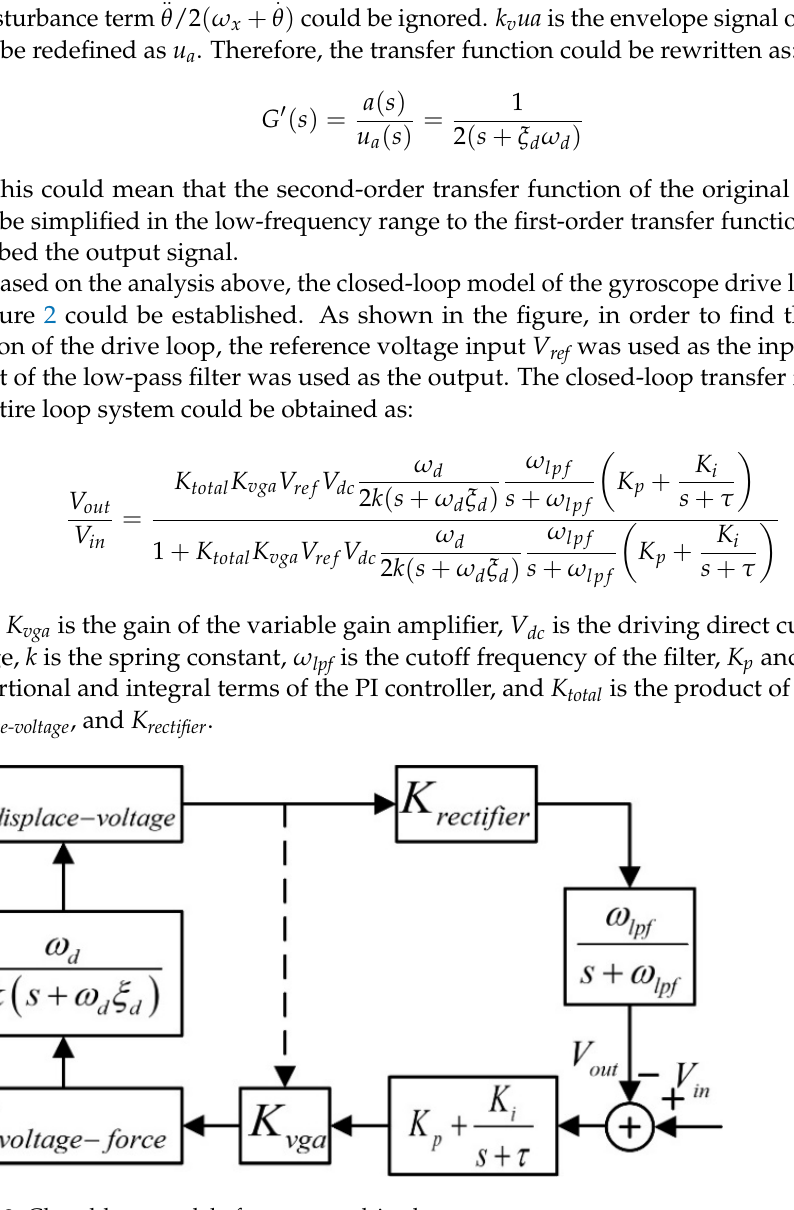
Figure 2. Closed-loop model of gyroscope drive loop.